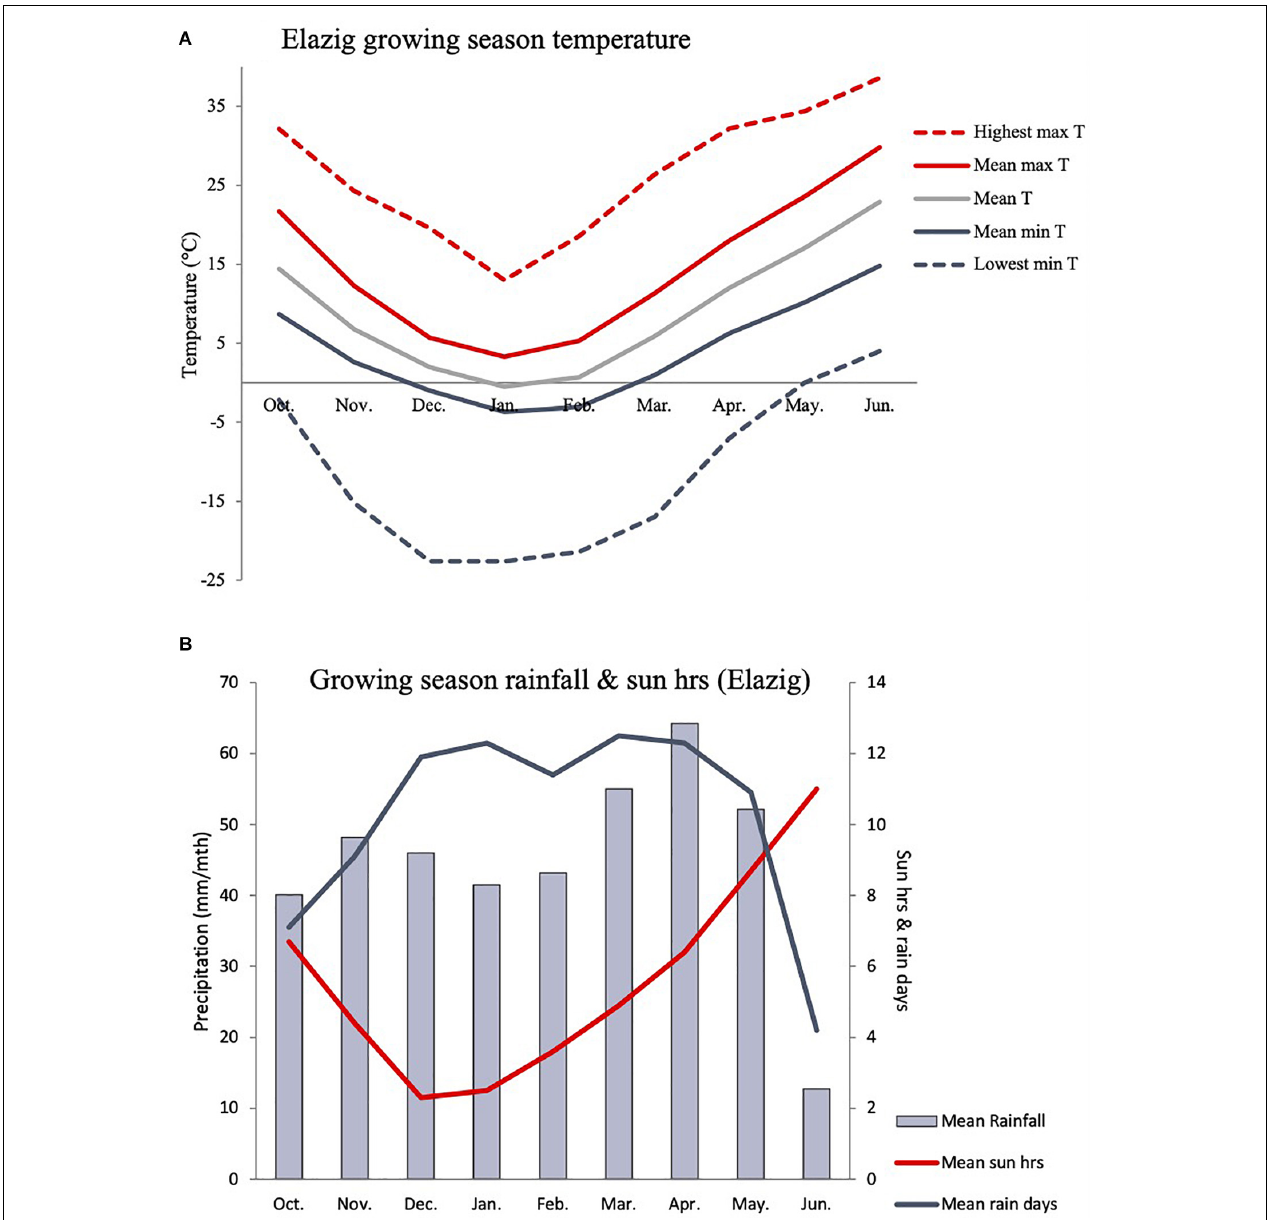
FIGURE 3 | Indicative C. turcicum growing season temperature (A) , precipitation and sun hours (B) based on long term monthly data (1981–2010) from the Elazig airport weather station (892 m asl), located 24.1 km from the Yedipinar collection site (1,548 m asl) at lower elevation (892 vs. 1,548 m). C. turcicum germinates in October, flowers in April/May and matures in June/July based on field observations and phenology data from common garden evaluation (see Figure 6